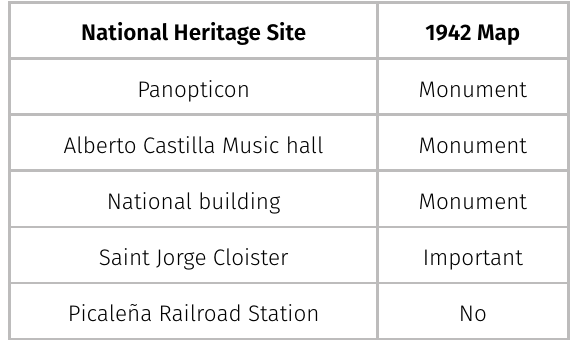
Table IV. National Heritage Site compared 2018-1942.